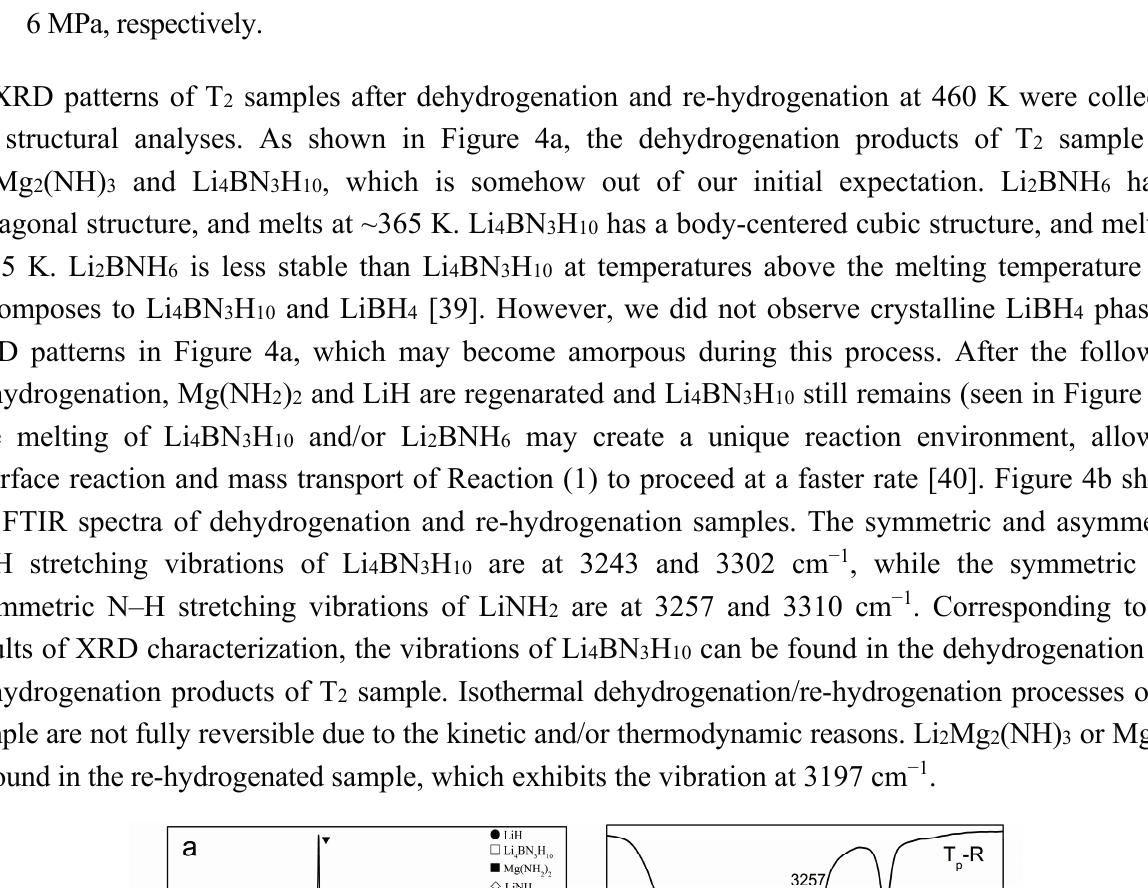
Figure 3. Isothermal hydrogen desorption and sorption of the 2Mg(NH 2 ) 2 –3LiH composite (T p ), 2Mg(NH 2 ) 2 –3LiH–LiBH 4 composite (T 2 ) at 416 K under the pressure of 0.01 and 6 MPa, respectively.